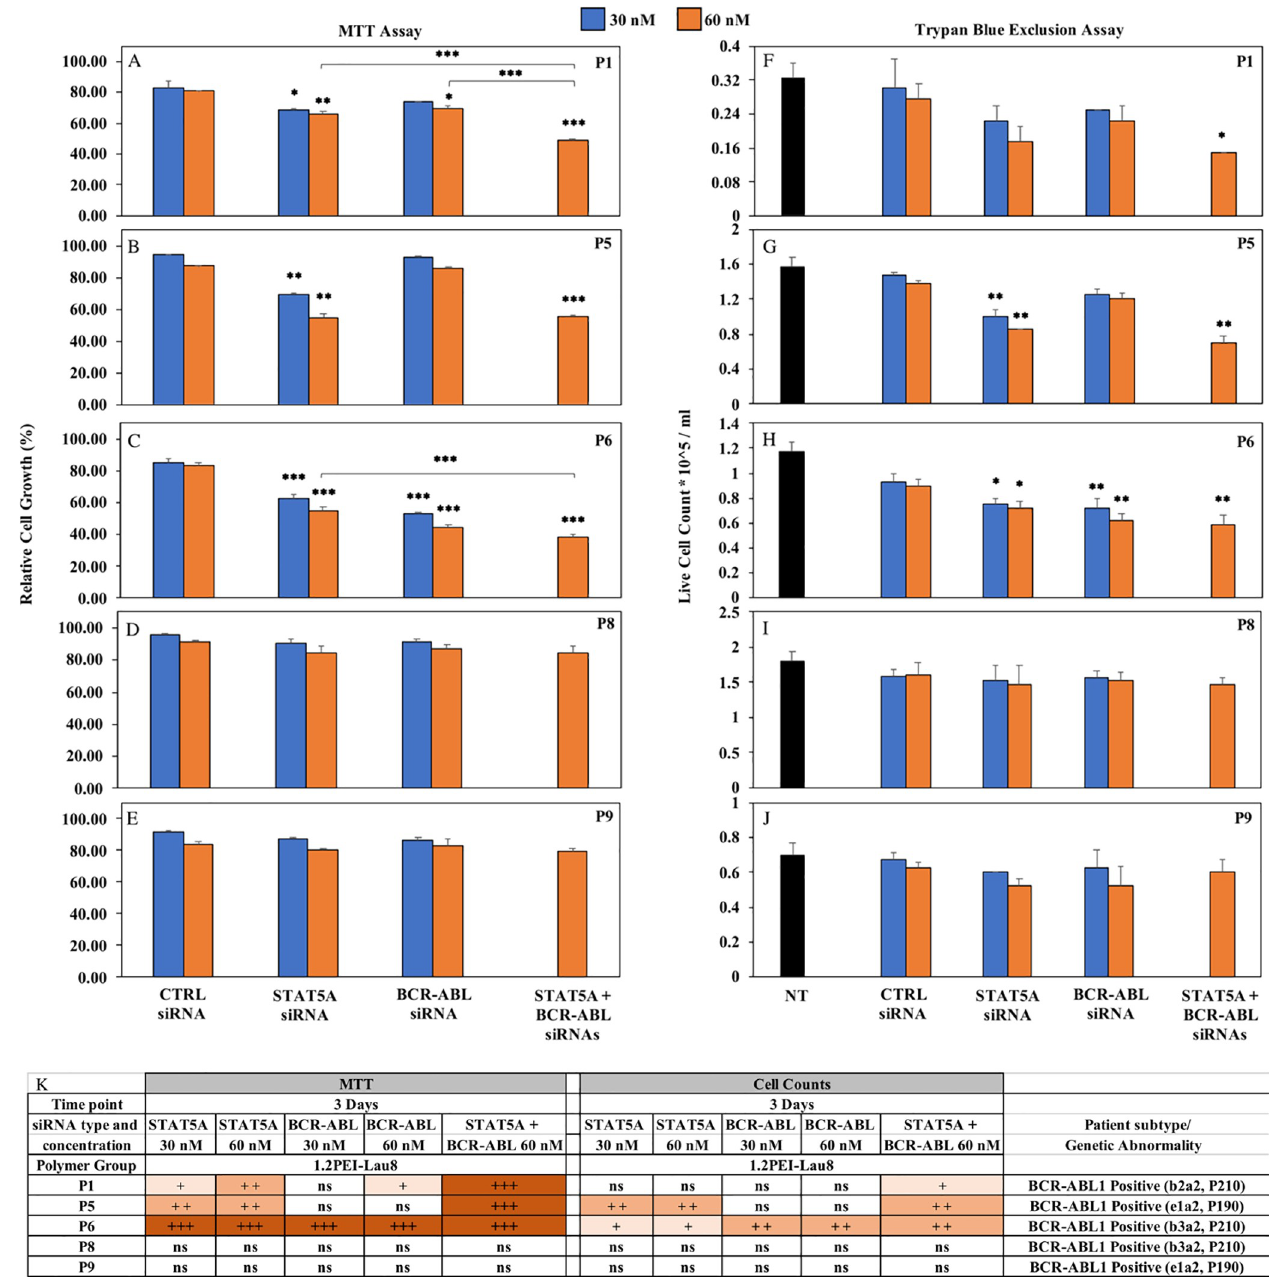
Fig 6. Effect of siRNA/polymer complexes on proliferation of BCR-ABL positive patient cells explored by MTT assay (A-E) and trypan blue exclusion assay (F-J). Cells were treated with 1.2PEI-Lau8/siRNA ratio of 6:1 and 30 nM and 60 nM of Control, STAT5A and BCR-ABL siRNAs for 3 days. Cell growth inhibition was assessed by MTT Assay and expressed relative to non-treated cells (taken as 100%). In addition, live cells were counted by trypan blue exclusion assay. Y-axis indicates the live cell count (x 10^5) per ml. Values are shown as means ± SD; (n = 3) � : p < 0.05, �� : p < 0.01, ��� : p < 0.001 versus control siRNA. (K). Summary of significant differences in MTT and cell counts in BCR-ABL positive patient